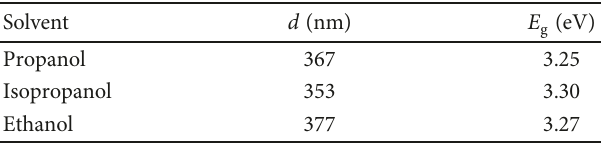
Figure 4: UV-Vis transmittance spectra of the ZnO thin fi lms with various solvents used. Table 2: The calculated values of the optical bandgap and thicknesses of the fi lms for di ff erent